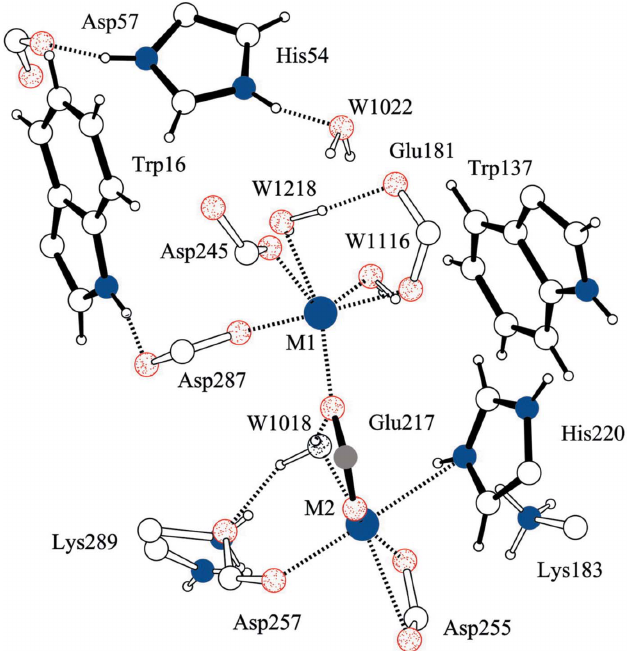
Figure 8 Active-site environment of XI as determined by neutron diffraction, showing the bimetal catalytic center and orientations of water molecules in the vicinity. Reprinted with permission from Katz et al. (2006), Proc. Natl Acad. Sci. USA , 103 , 8342–8347. Copyright (2006) National Academy of